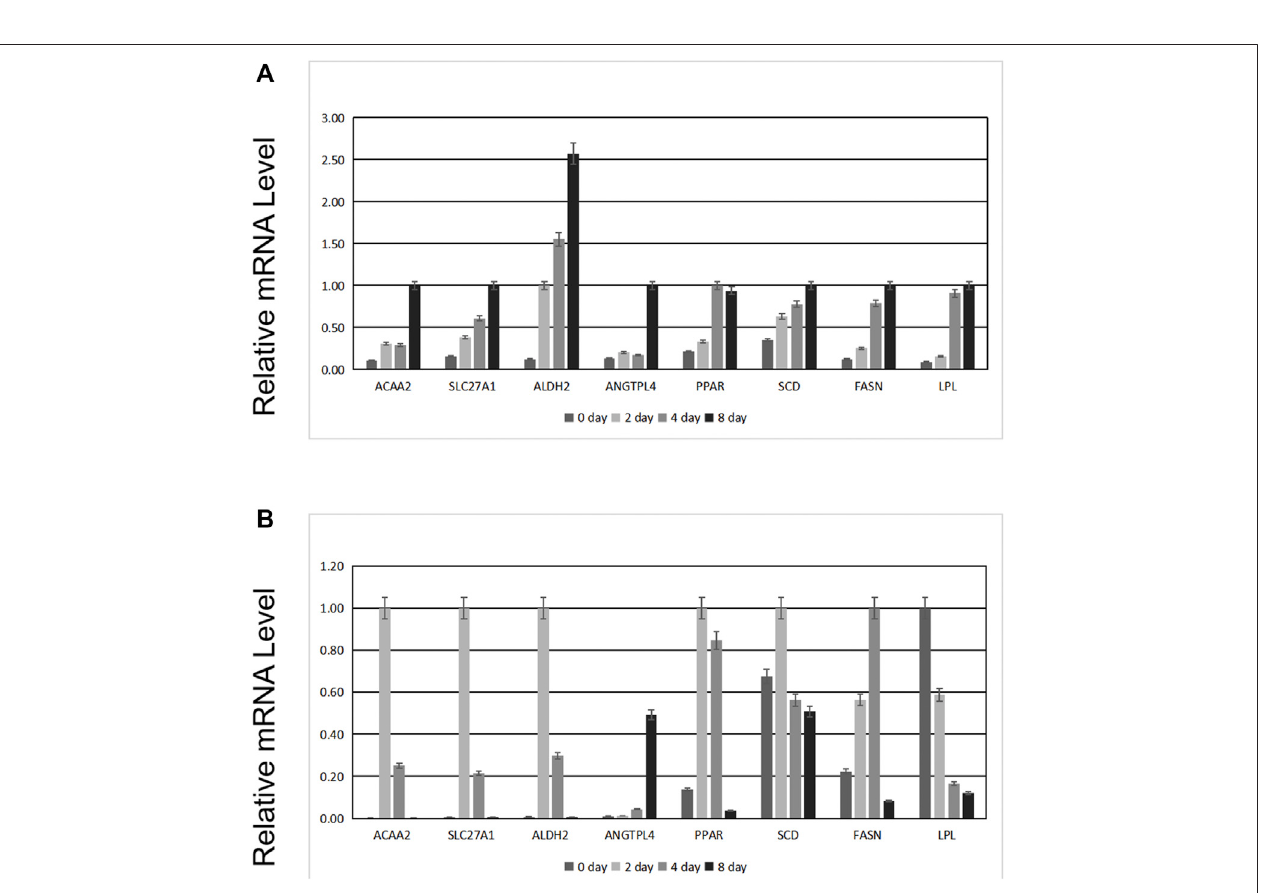
Frontiers in Genetics |